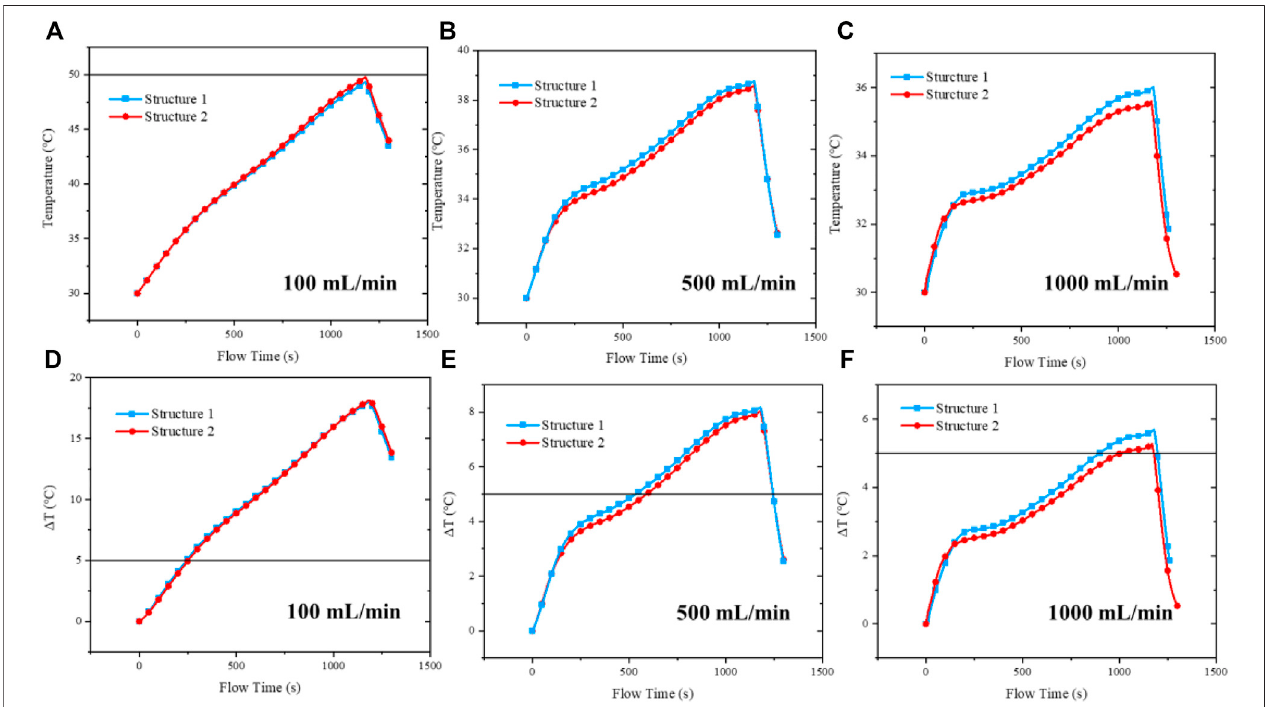
FIGURE 10 | Comparison of temperature (A – C) and maximum temperature difference (D – F) between two inlet/outlet fl ow structures.